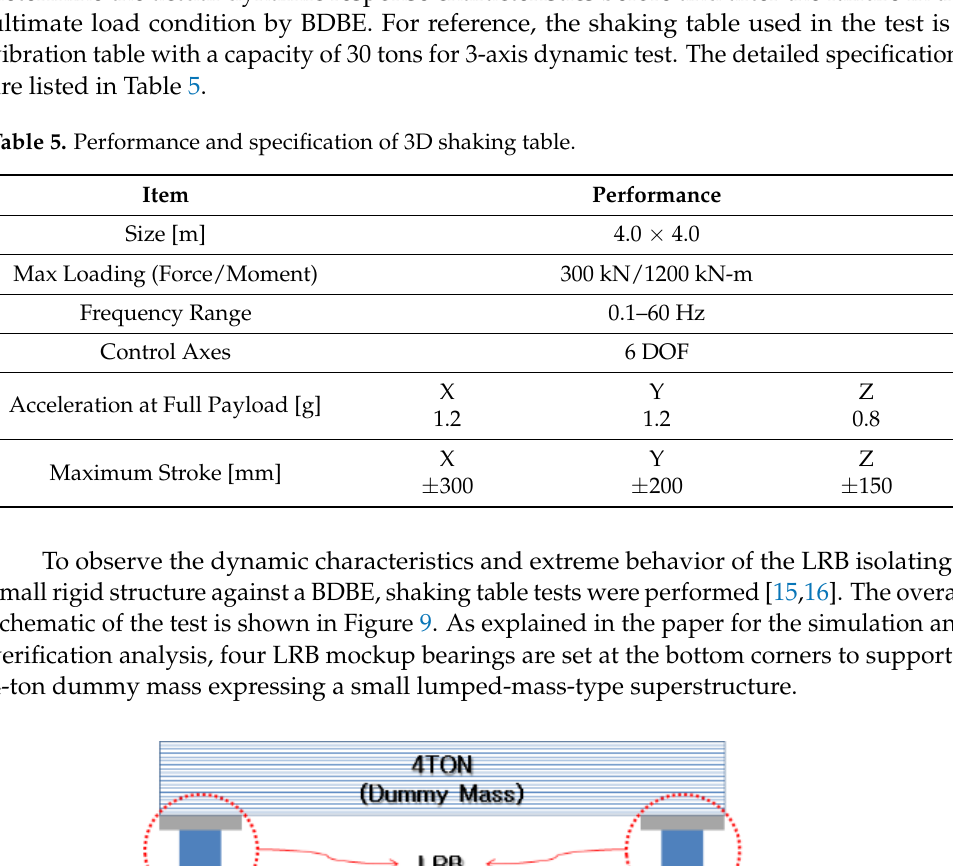
Figure 8. Analysis results of LRB simulating shaking table tests (DBE: 0.6 g): ( a ) steel layer; ( b ) rubber layer.